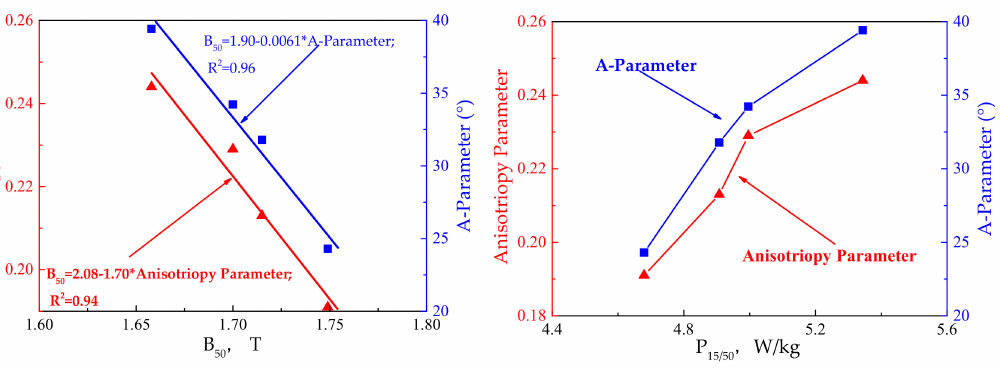
→ h ) on magnetic properties